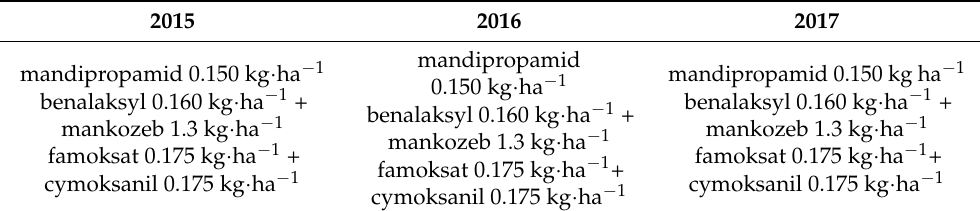
Table 1. Doses of fungicides applied in standard cultivation practices,